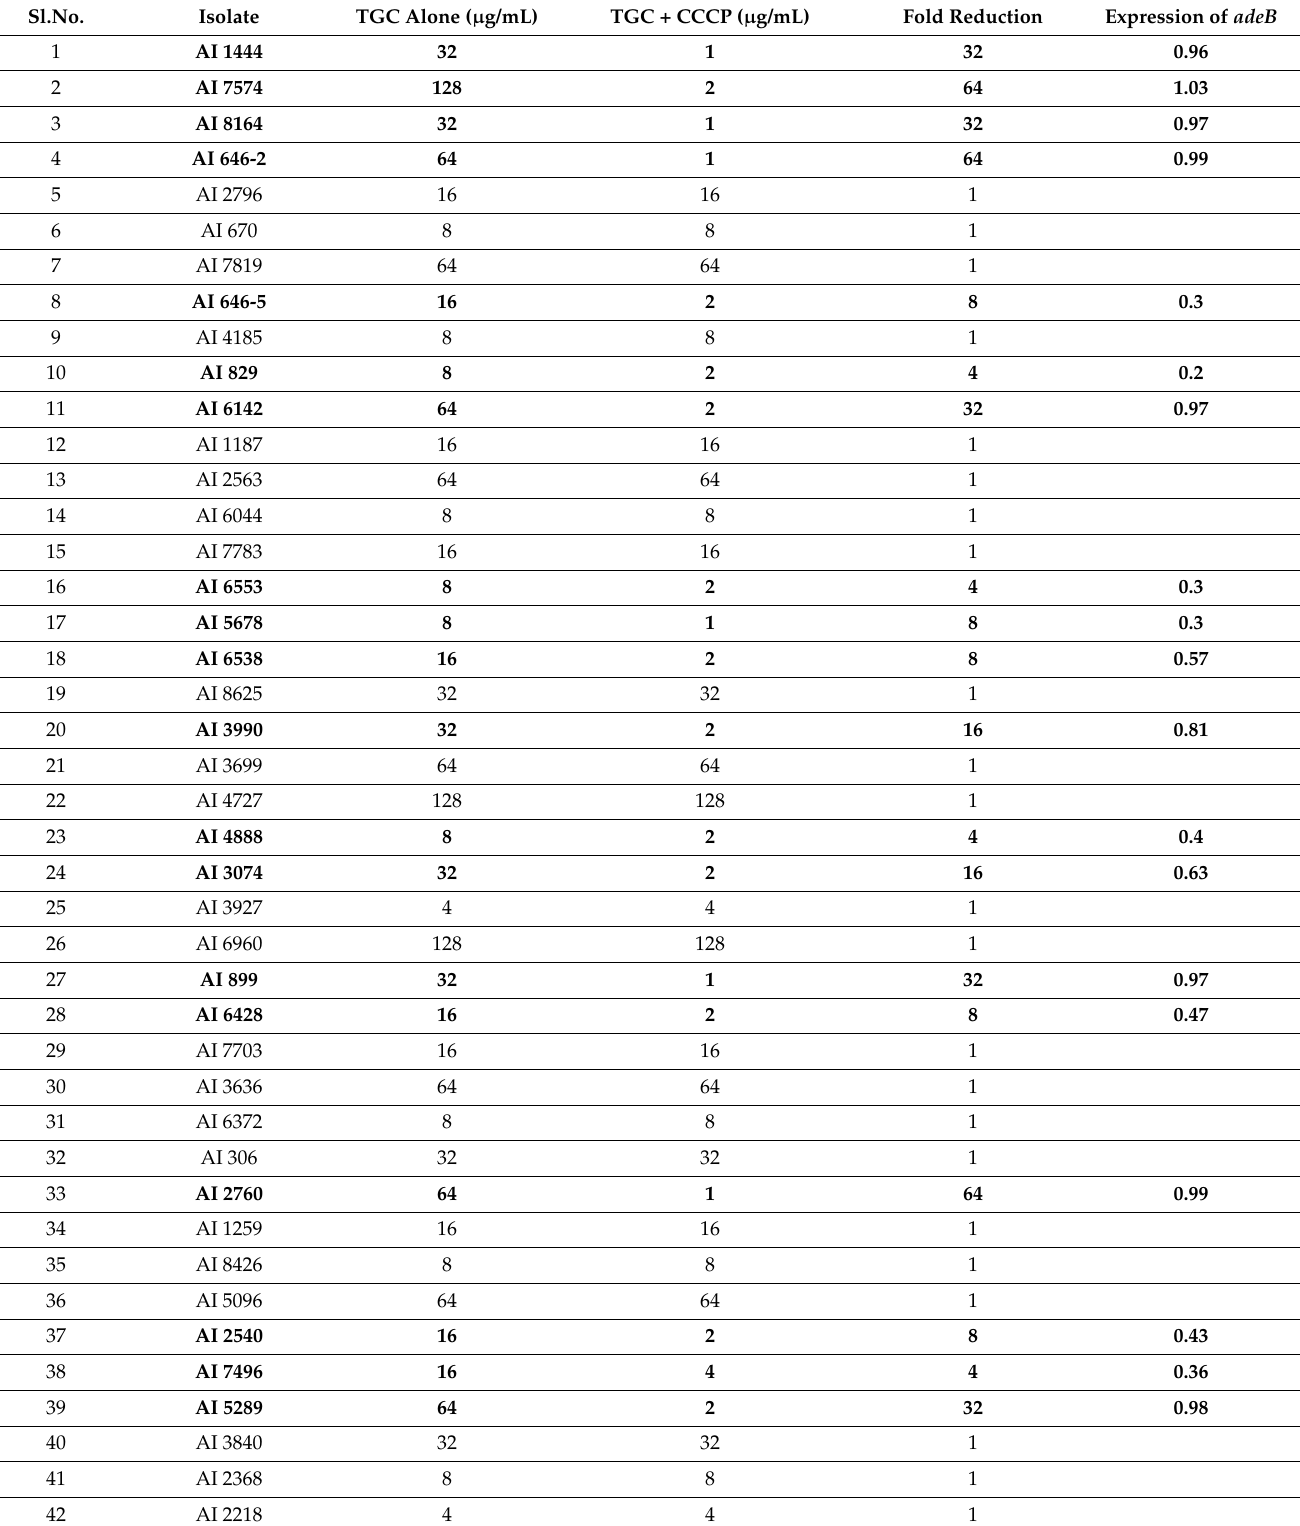
Table 2. Phenotypic detection of an efflux pump in tigecycline-resistant isolates by using CCCP and the associated MIC fold reduction, along with adeB gene expression